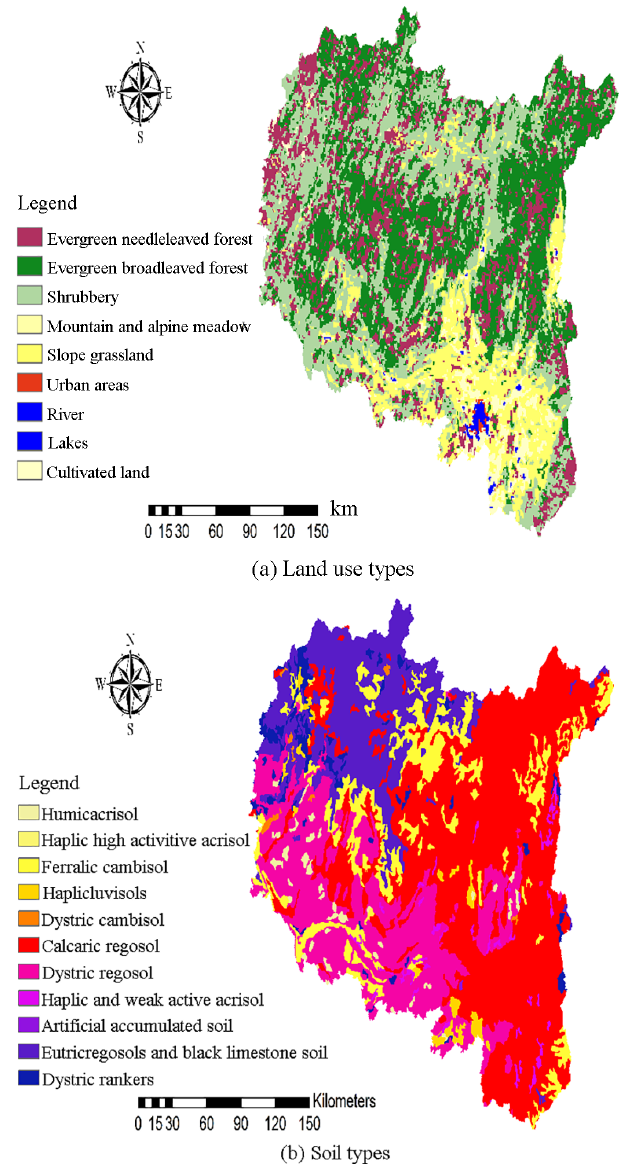
Figure 3. The property data for the Liuxihe model in the LKRB.